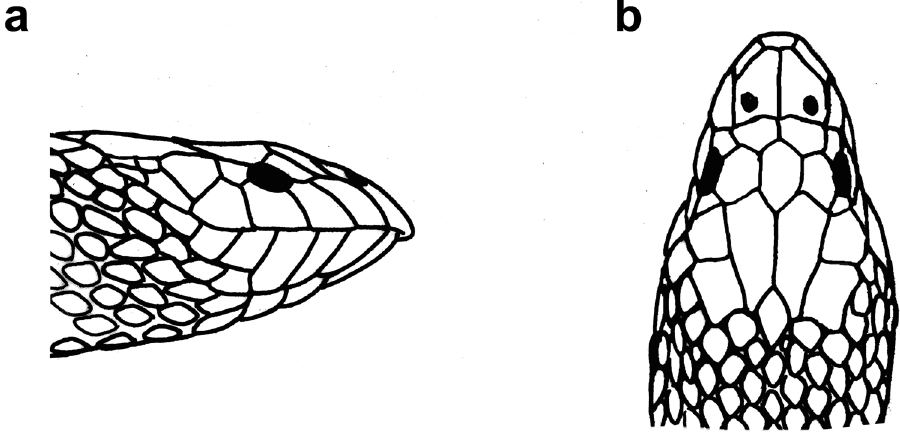
Figure 23. Head of Microcephalophis gracilis : a lateral view b dorsal view.